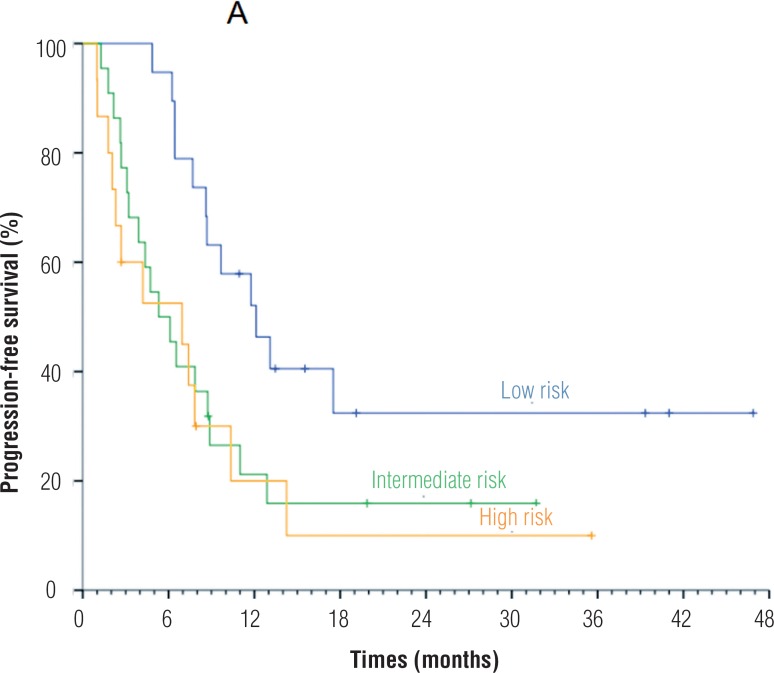
Progression free survival according to MSKCC risk groups.p-value = 0.029 by Log Rank test